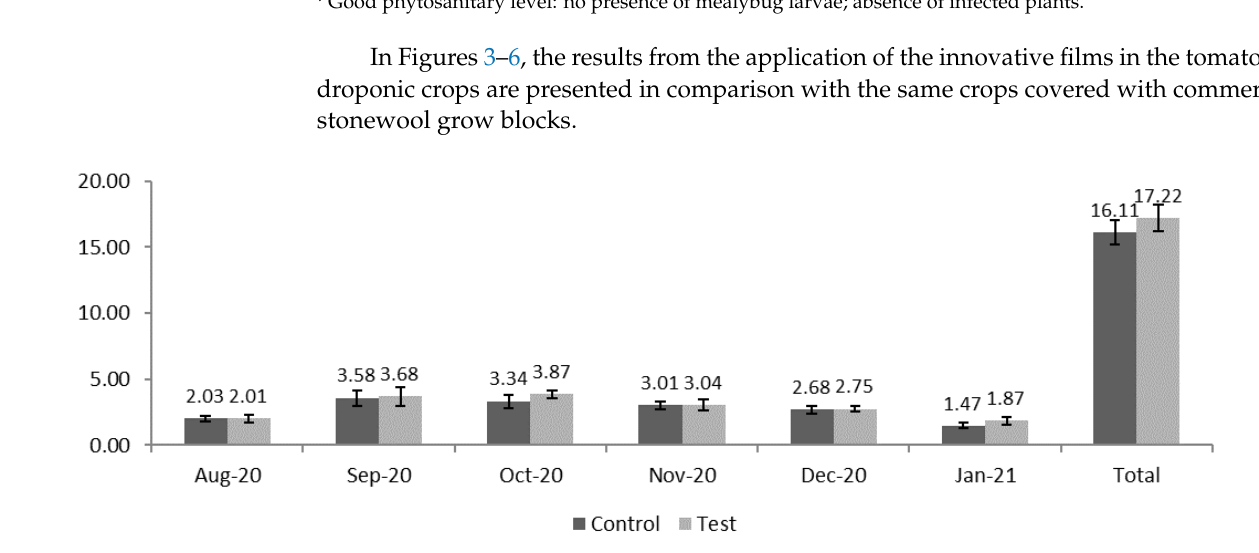
Figure 2. Application of the polymeric films with the encapsulated bioactive agents on tomato hy- droponic crops cultivation.